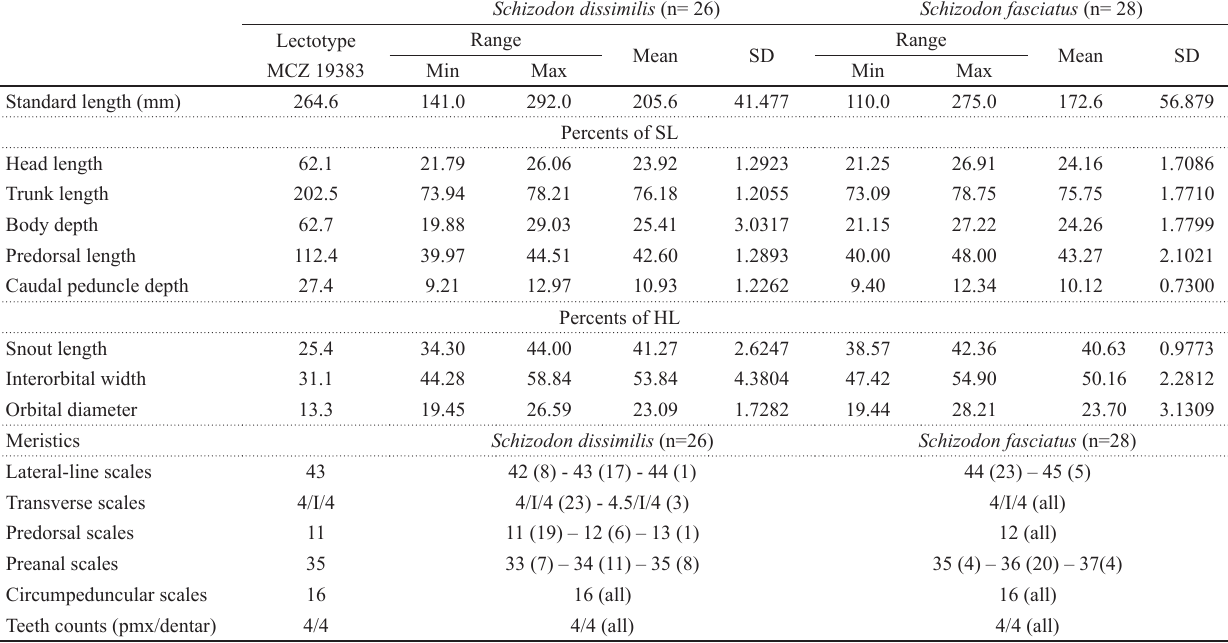
Tab. 3. Morphometrics of Schizodon dissimilis and S. fasciatus expressed as percentages of SL and HL. Meristic data with numbers of specimens with each count in parenthesis. All lectotype data in